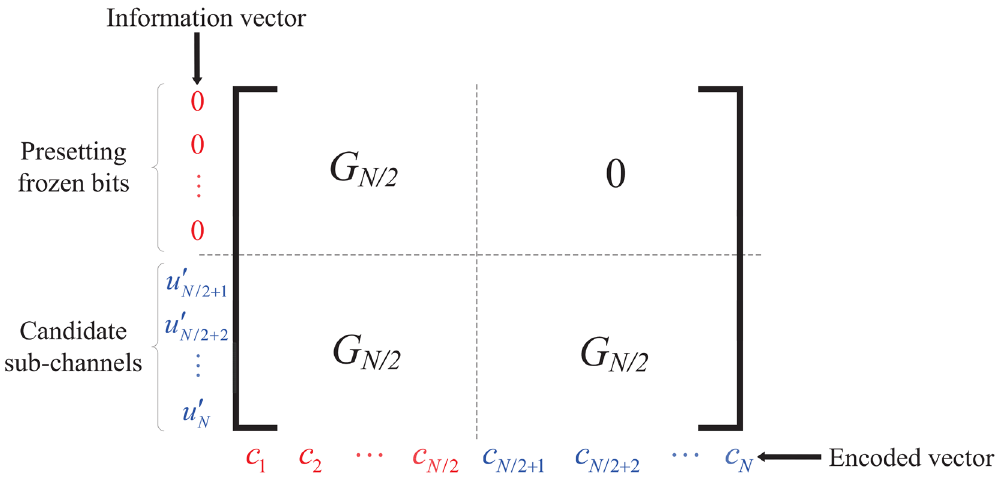
Figure 2. The proposed encoded procedure.